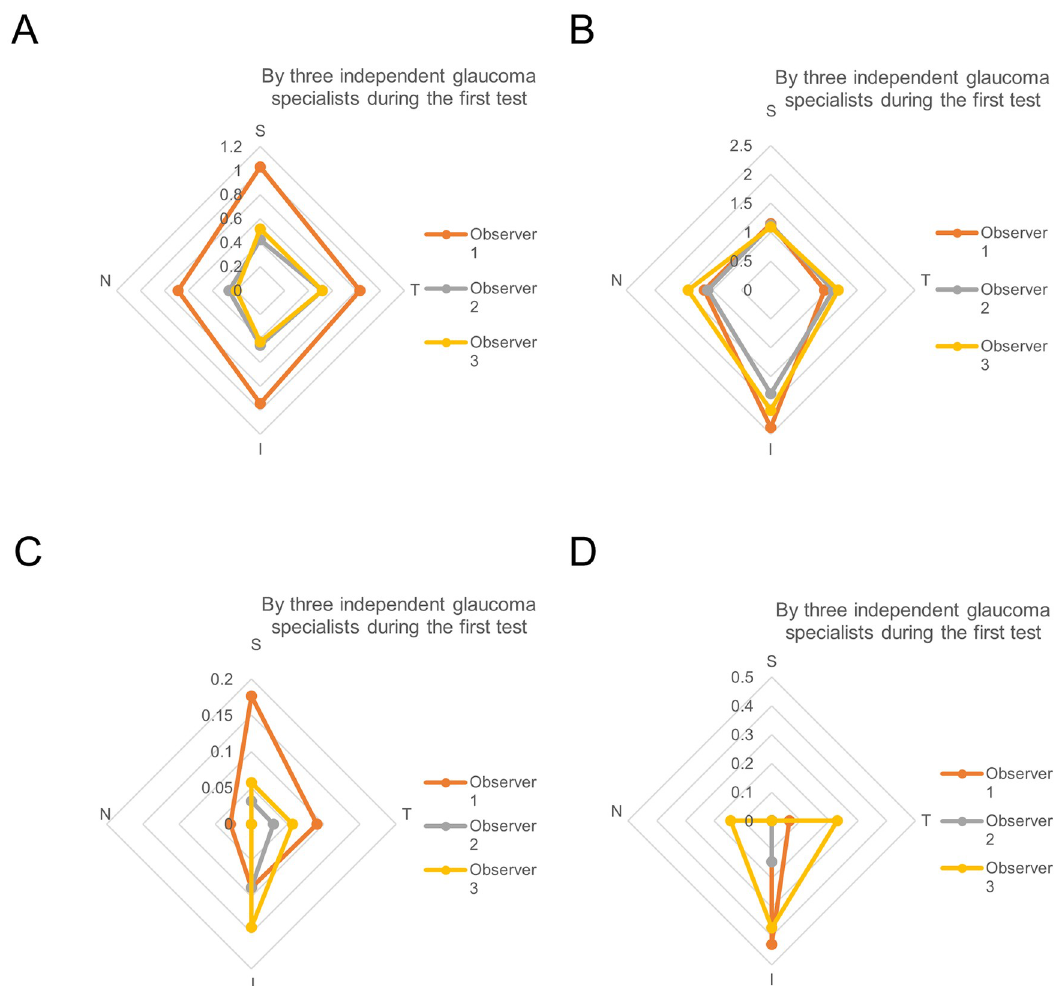
Fig 2. The radar charts of the mean distributions of iridocorneal angle evaluations during the first test by three independent glaucoma specialists for visualizing interobserver variabilities in (A) Scheie’s angle width grading (0 to 4), (B) Scheie’s angle pigmentation grading (0 to 4), (C) PAS detection (0 to 1), and (d) Sampaolesi line detection (0 to 1). S = superior; T = temporal; I = inferior; N =